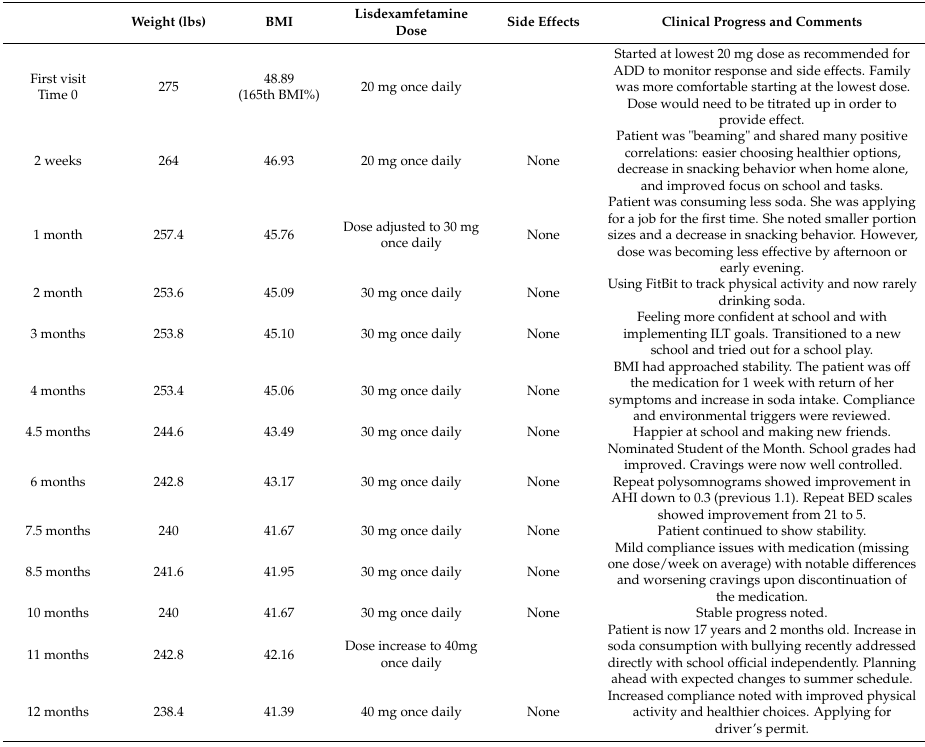
Table 1. Summary of the patient’s consecutive visits at the pediatric weight management center over